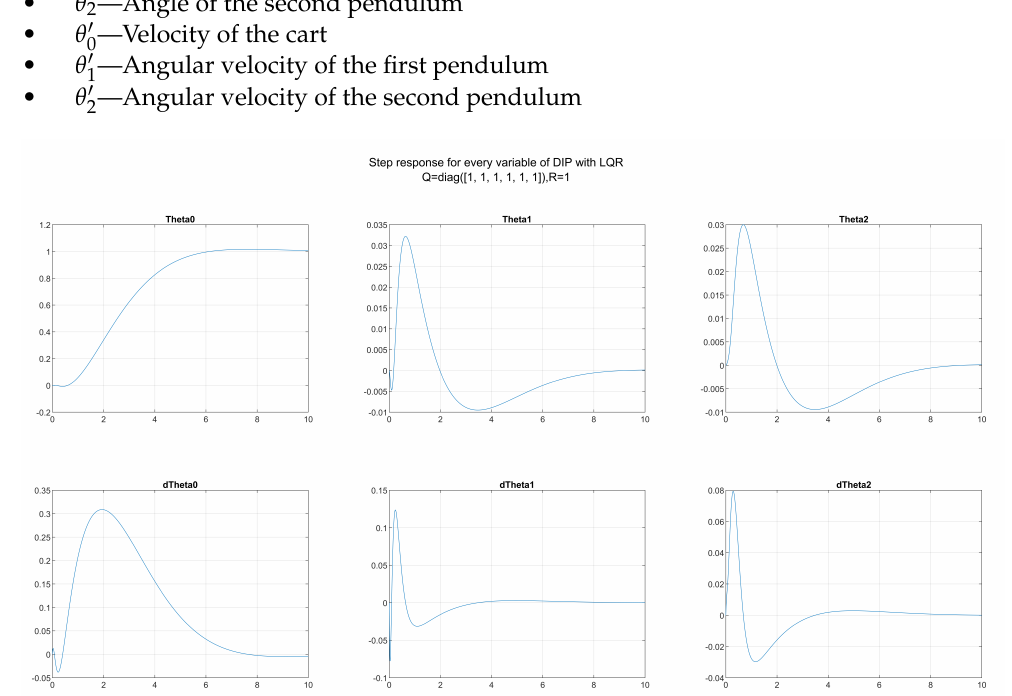
Figure 6. Step response of the